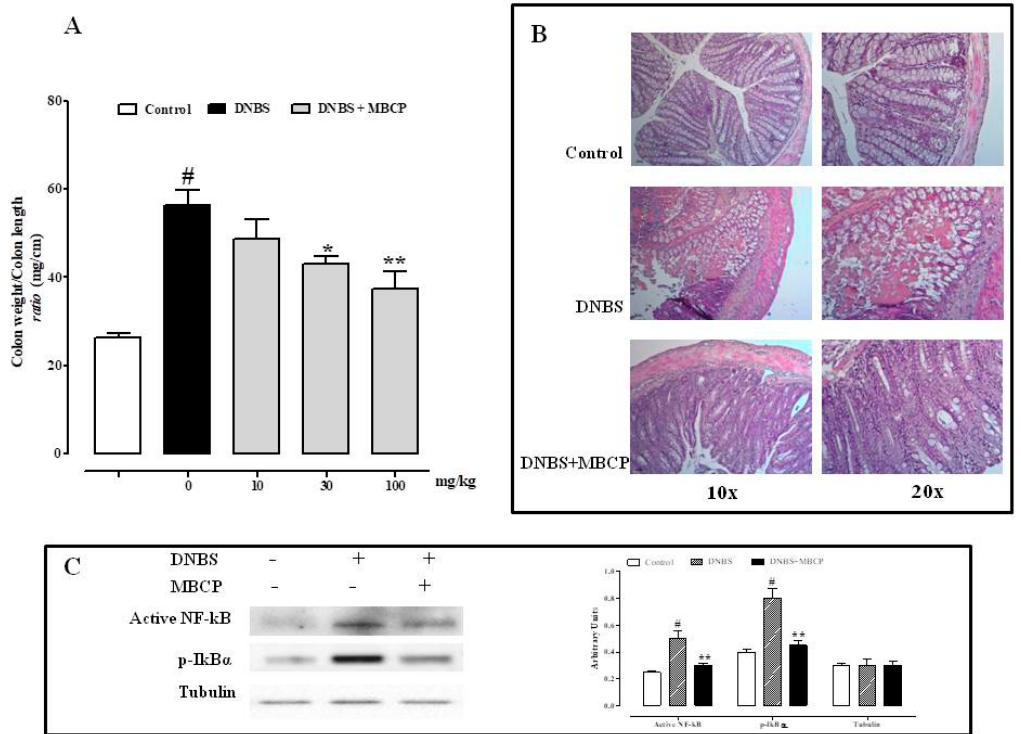
Figure 6. MBCP reduces colon weight/colon length ratio in DNBS-induced colitis in mice. ( A ) MBCP (10–100 mg/kg, by oral gavage) was administered once a day starting 24 h after the induction of colitis by DNBS (150 mg/kg). Colons were collected three days after DNBS. ( B ) representative hematoxylin & eosin stained colon cross-sections of mice treated with vehicle (control), DNBS and DNBS plus MBCP (100 mg/kg by oral gavage). Colons were collected three days after the induction of colitis by DNBS. Original magnification 10 × and 20 × (A). ( C ) Western blot analysis of p-NF- κ B, NF- κ B, and house-keeping γ -tubulin expression in normal mice colon and after the induction of colitis by DNBS.All data are represented as mean ± SEM of seven mice for each experimental group. Statistical significance was calculated using one-way ANOVA test. # p < 0.001 vs. control, * p < 0.05 and ** p < 0.01 vs. DNBS alone;.